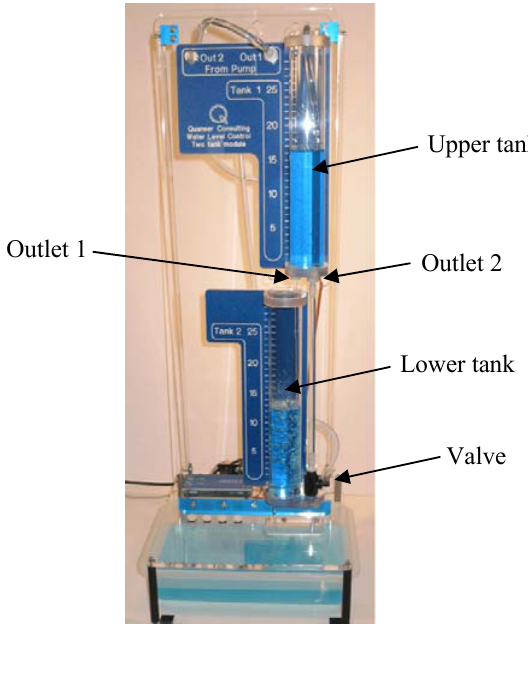
Figure 8. The two-tank system. In the experiments, just control level of the upper tank has been done. Disturbances are introduced into the system by the second outlet located in the upper tank bottom. This outlet is closed and open manually by a valve located near the bottom right of the lower